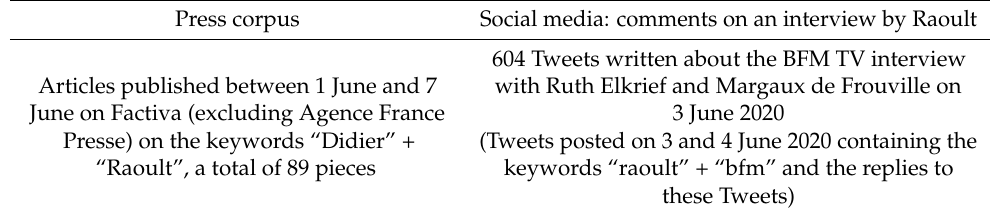
Table 1. Description of the two